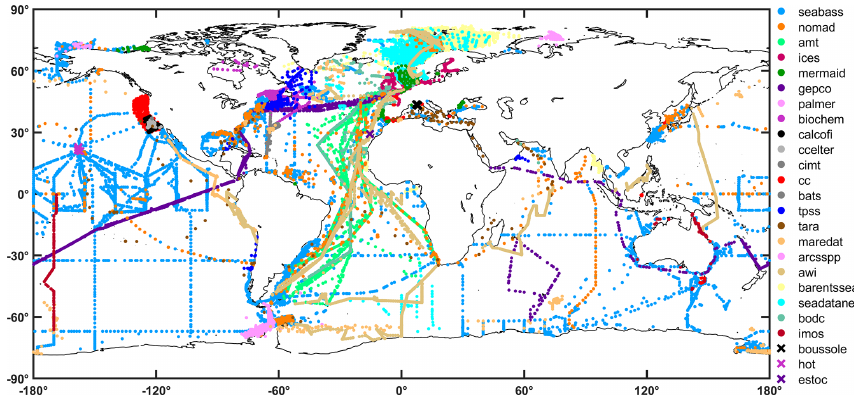
Figure 9. Global distribution of chlorophyll- a concentration per data set in the final table. All chlorophyll data were considered, but for a given station, HPLC data were selected if available. Crosses show sites from where data of chlorophyll are available in a specific geographic